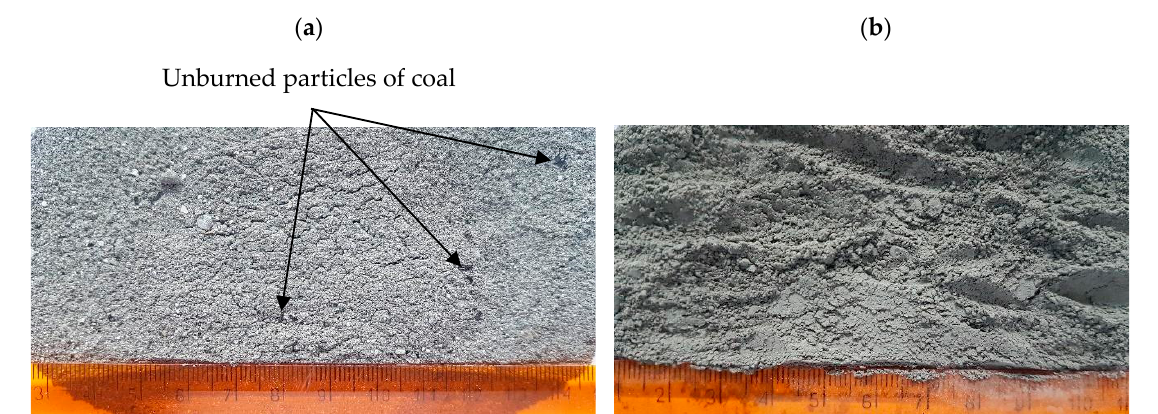
Table 2. Heavy metal concentrations, expressed in mg/kg. Figure 2. The tested fly ash (FA): ( a ) draw; ( b ) mechanically crushed. Figure 2. The tested fly ash (FA): ( a ) draw; ( b ) mechanically crushed.